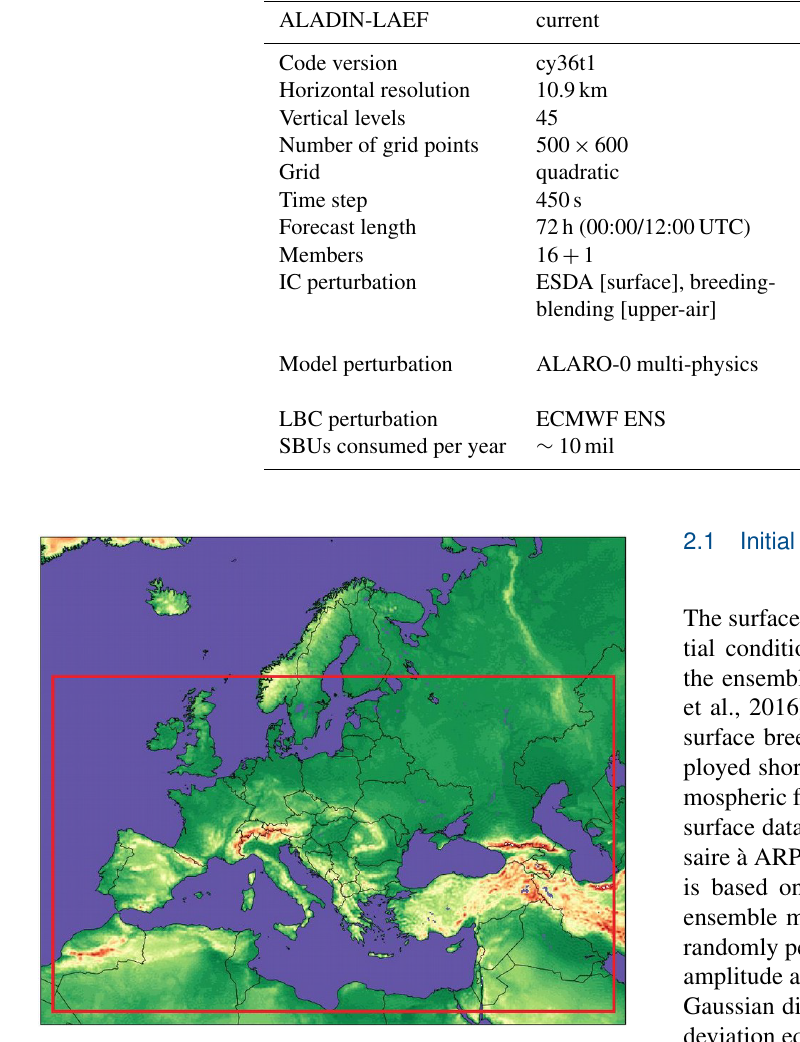
Figure 1. Current and new (red rectangle) ALADIN-LAEF com- putational